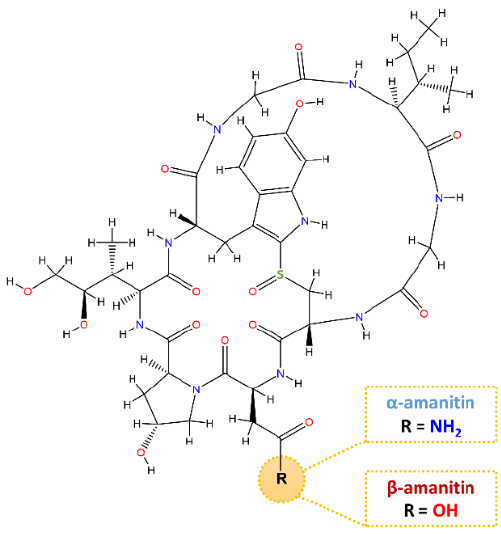
Figure 1. Chemical structure of α - and β -amanitin.